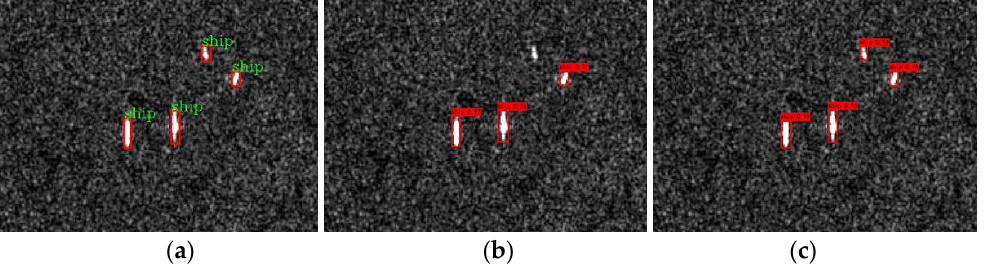
Figure 17. Detection of dense small ships in SAR images. ( a ) Correct position of the ship in the SAR image; ( b ) Ship detection effect of YOLO V5 in SAR images; ( c ) Ship detection effect of FLNet in SAR images.